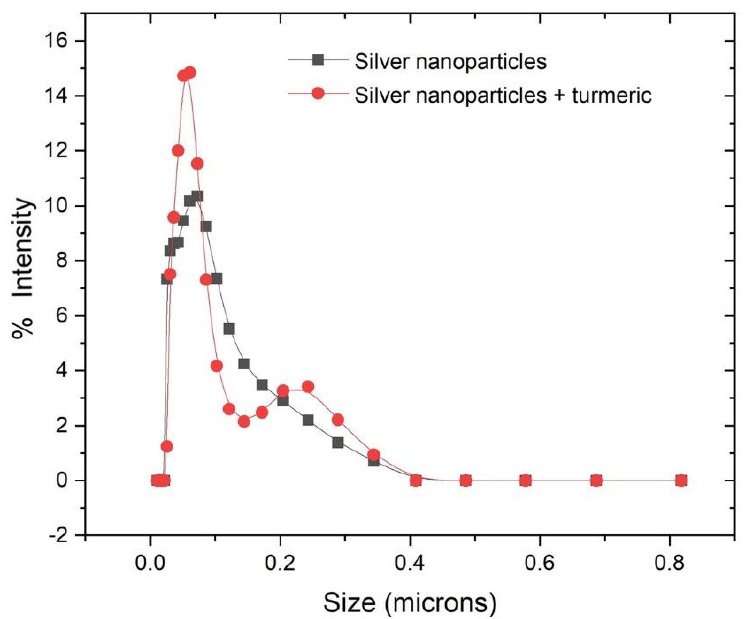
Figure 11. DLS curve of AgNPs and the phytocarrier system.